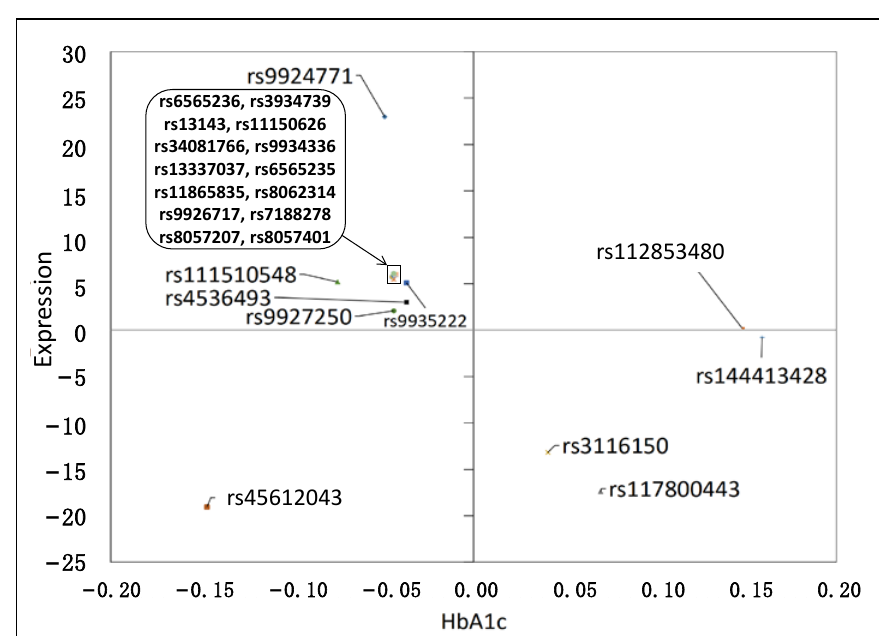
Figure 4. Effects of SNPs on HbA1c and SLC5A2 gene expression. Schemes follow another format. X-axis: Betas for HbA1c (mmol/mol) from the UK Biobank. Y-axis: ( A ) Estimates for SLC5A2 gene expression in the TransplantLines cohort, ( B ) Betas for SLC5A2 gene expression in the NephQTL resource, ( C ) Z-scores for SLC5A2 gene expression in the eQTLGen